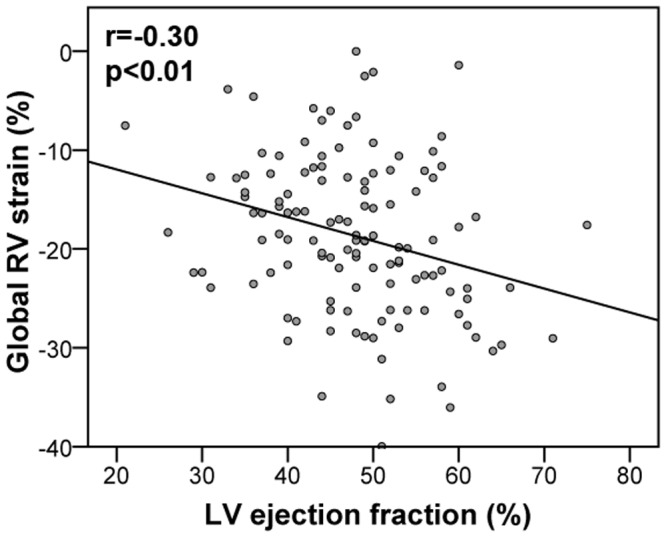
Global right ventricular strain plotted against left ventricular ejection fraction.Global RV strain correlated significantly with LV ejection fraction determined in CMR imaging. LV = left ventricular; RV = right ventricular.